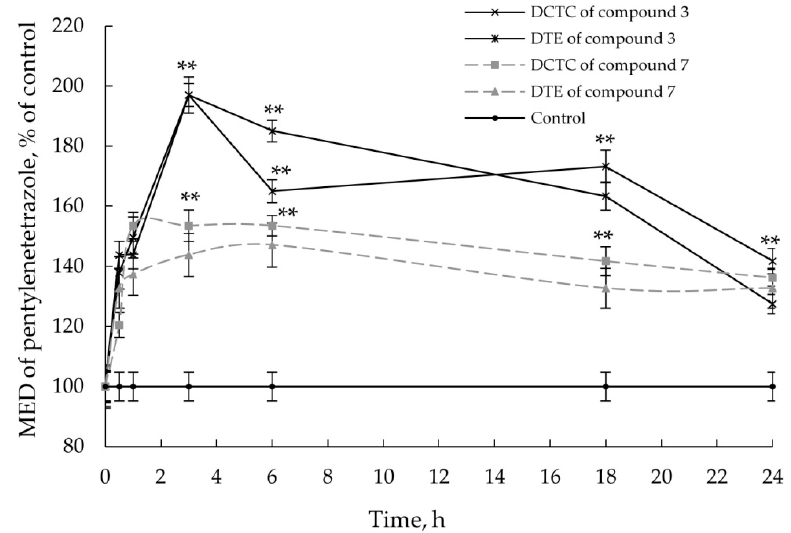
Figure 2. Anticonvulsant activity of compounds 3 and 7 ; time-response relationship. Values are given as mean ± SEM, n = 5 mice; ** p < 0.01 compared with vehicle control. One-way analysis of variance (ANOVA) followed by Tukey’s post hoc comparison.